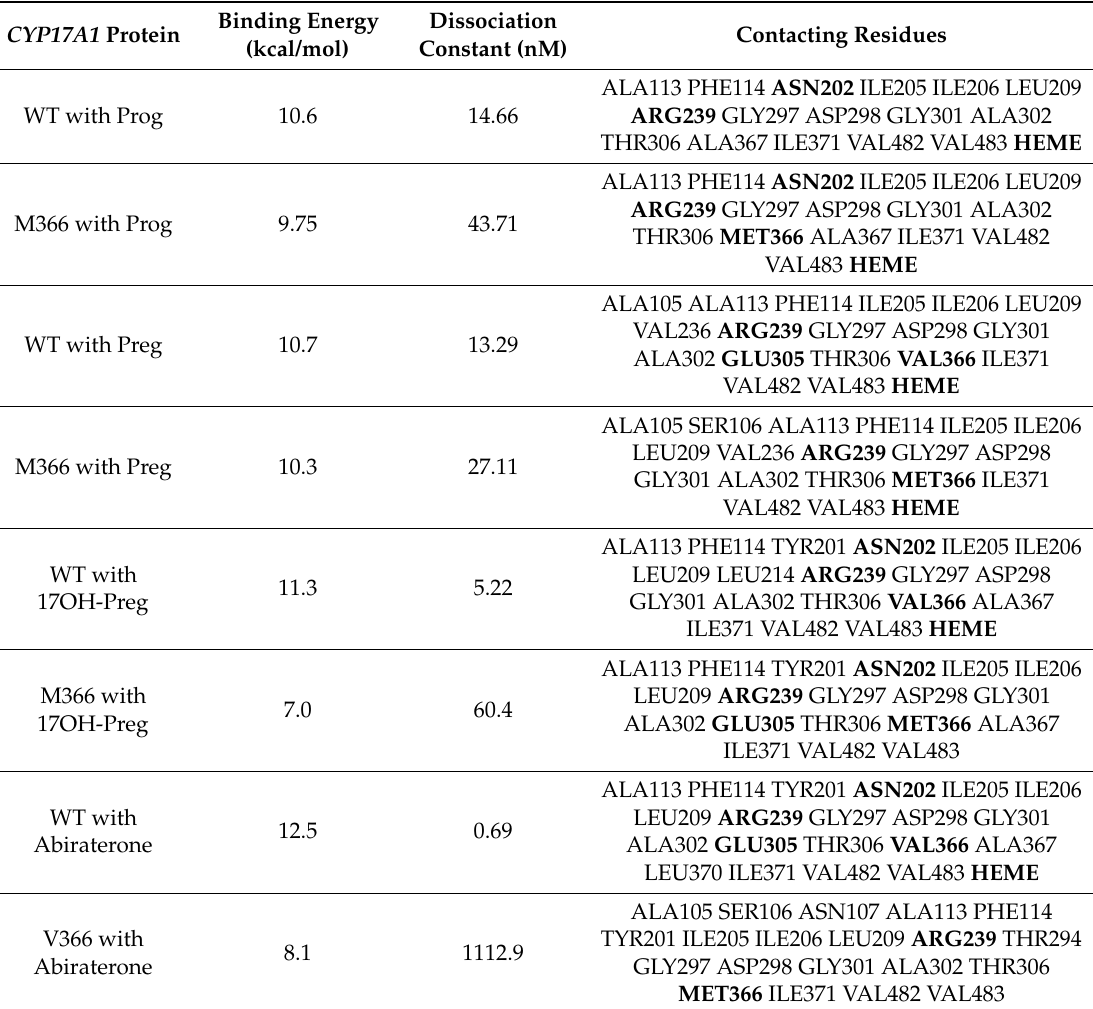
Table 6. Computational binding energy, computationally calculated dissociation constants, and interacting residues for steroid substrates and abiraterone with WT and the V366M mutant of CYP17A1 . Key residues identified in different studies are shown in